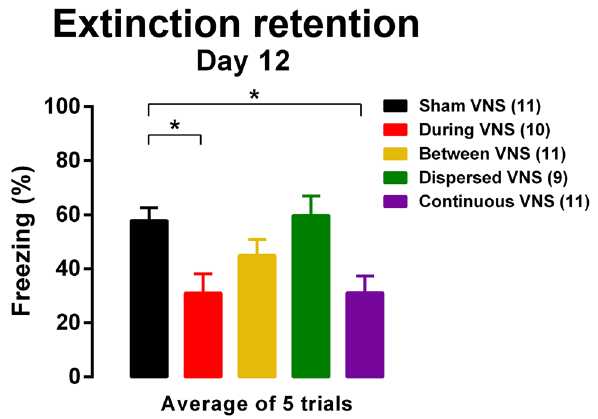
Figure 3. Extinction learning is maintained after 7 days of VNS-paired extinction. Rats that received during VNS or continuous VNS showed nearly 50% improvement in extinction recall compared to Sham VNS rats a week after extinction training. Data are represented by the mean ± SEM using the average of the 5 trials from the retention session, and analyzed by on-way ANOVA. * p < 0.05 (Bonferroni’s post hoc test). Sham (n = 11), VNS during (n = 10), VNS between (n = 11), VNS dispersed (n = 9), VNS continuous (n = 11).